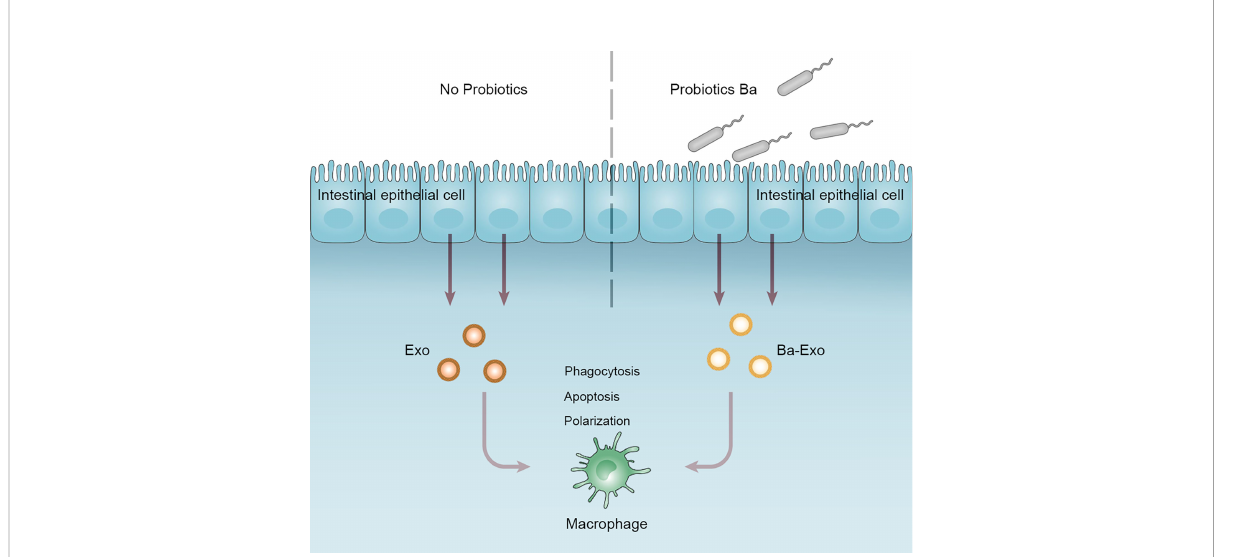
FIGURE 7 Working model depicting a proposed role of Ba-Exo modulating M j function. Exosomes (Ba-Exo) released from intestinal porcine epithelial cells treated with Ba had no effect on M j apoptosis. However, they can enter M j , promote phagocytosis of M j , and stimulate M j polarization to M1. Ba, Bacillus amyloliquefaciens SC06; Exo, exosomes derived from untreated IPEC-J2; Ba-Exo, exosomes secreted from Ba-induced